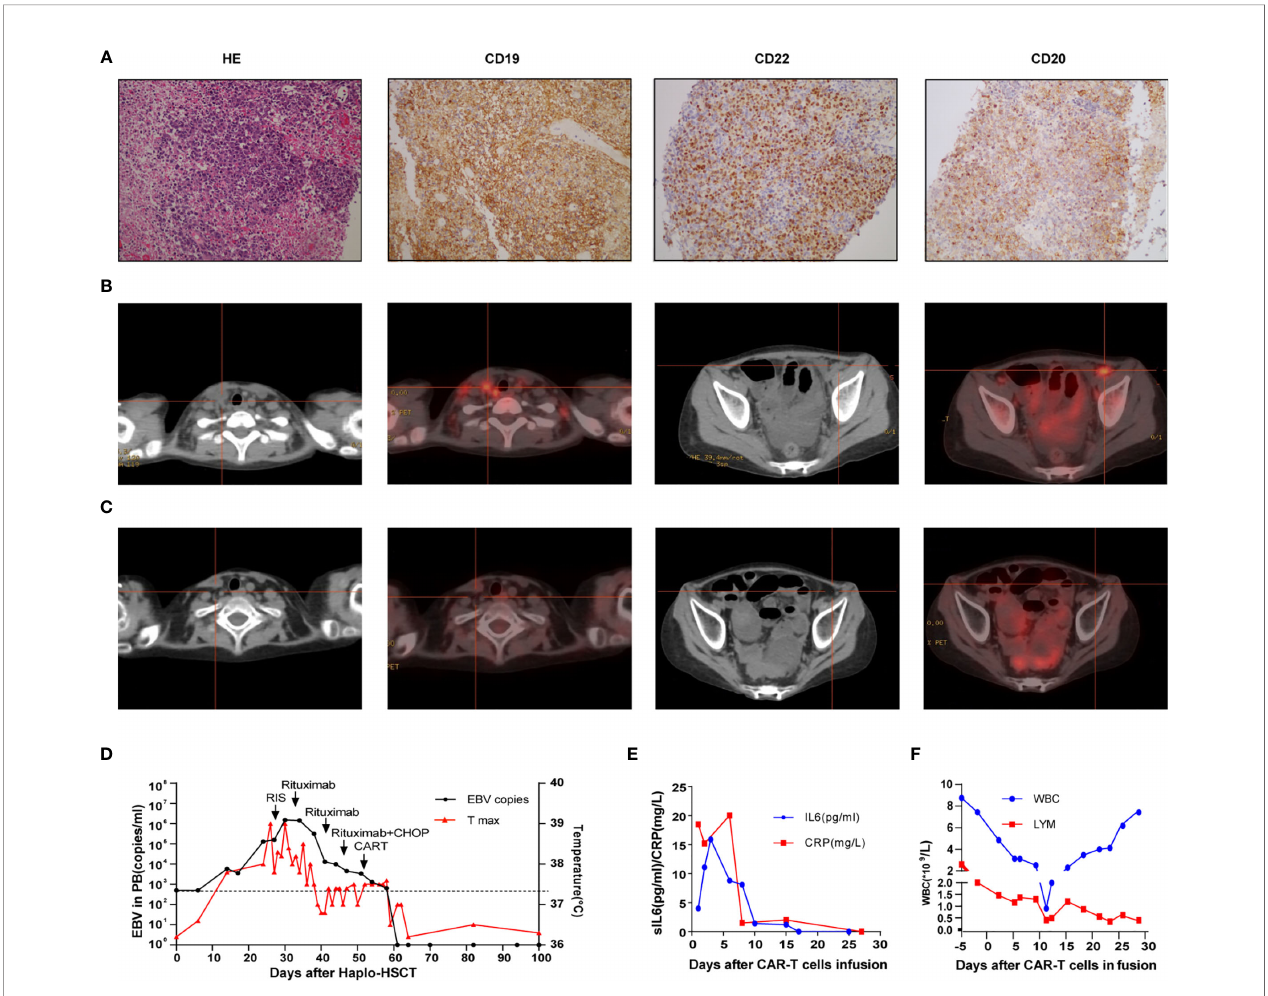
FIGURE 2 | Cervical lymph node biopsy of case 2 (A) ; Computed tomography and positron emission tomography images before (B) and after treatment (C) ; Timeline of EBV PCR and clinical data (D) ; CRP, sIL6 (E) and peripheral hemogram (F) after CAR-T